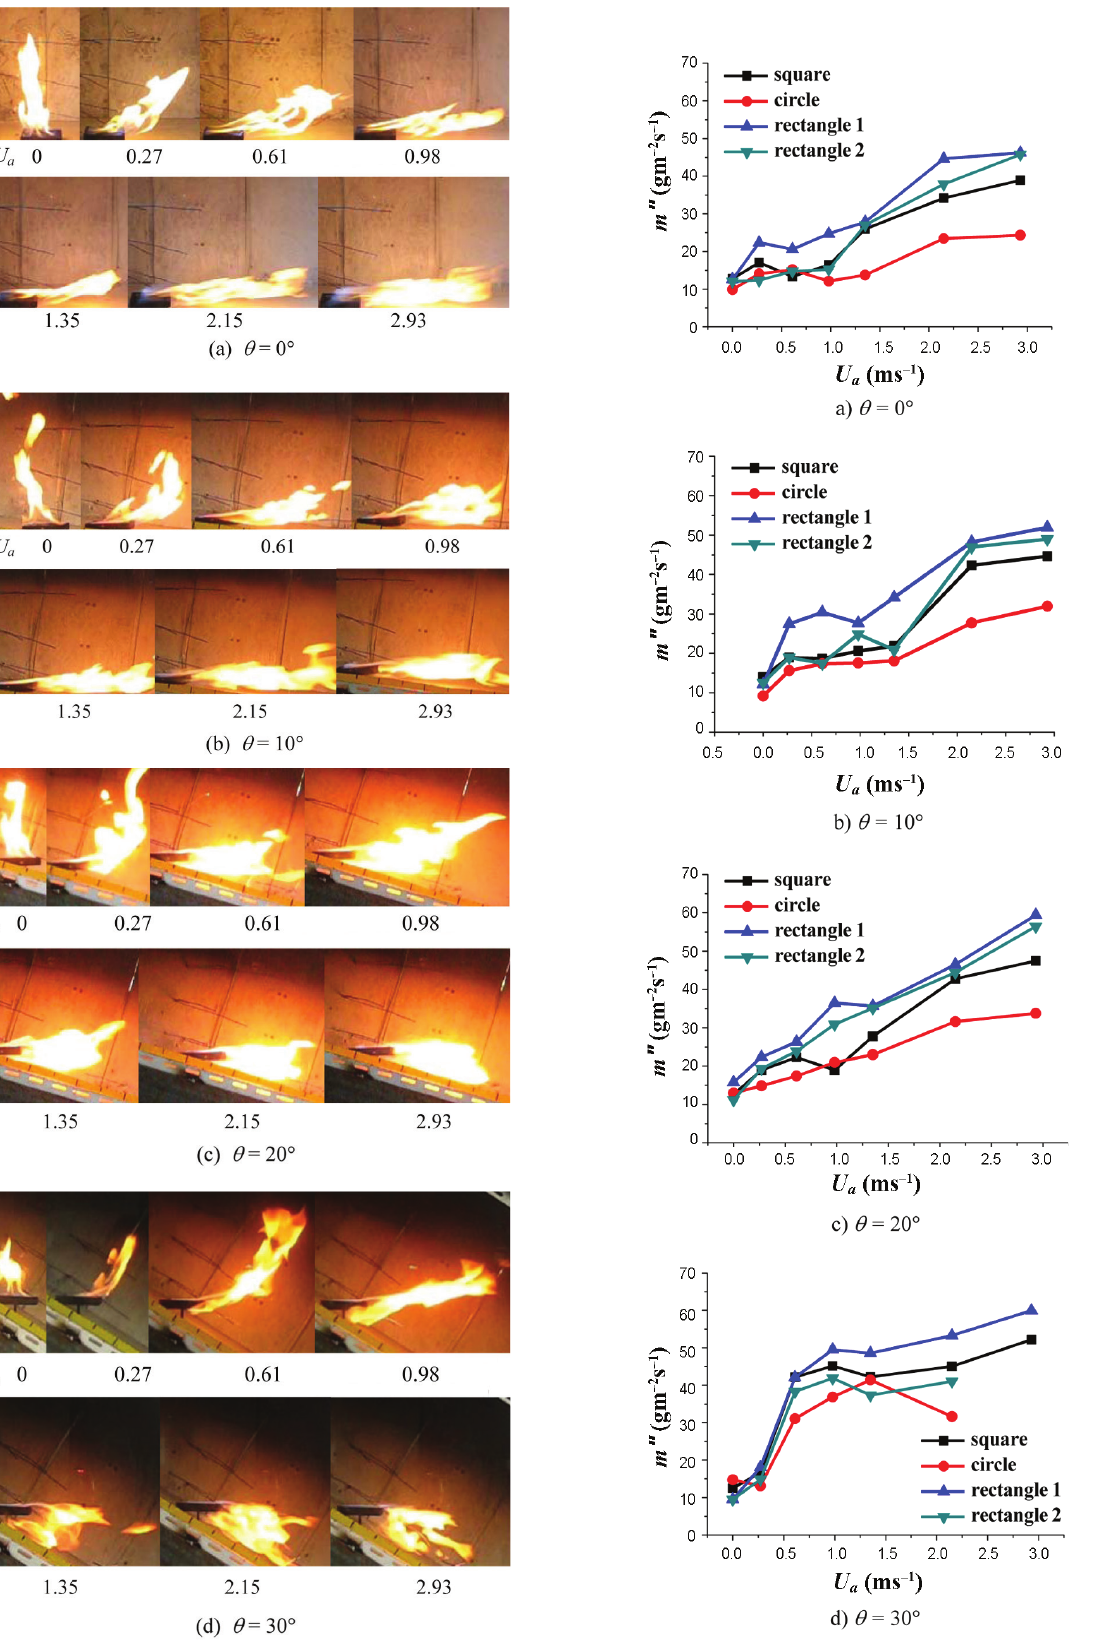
Fig. 4. Stretching of flames of square pool fire at 10 cm under different degree lean